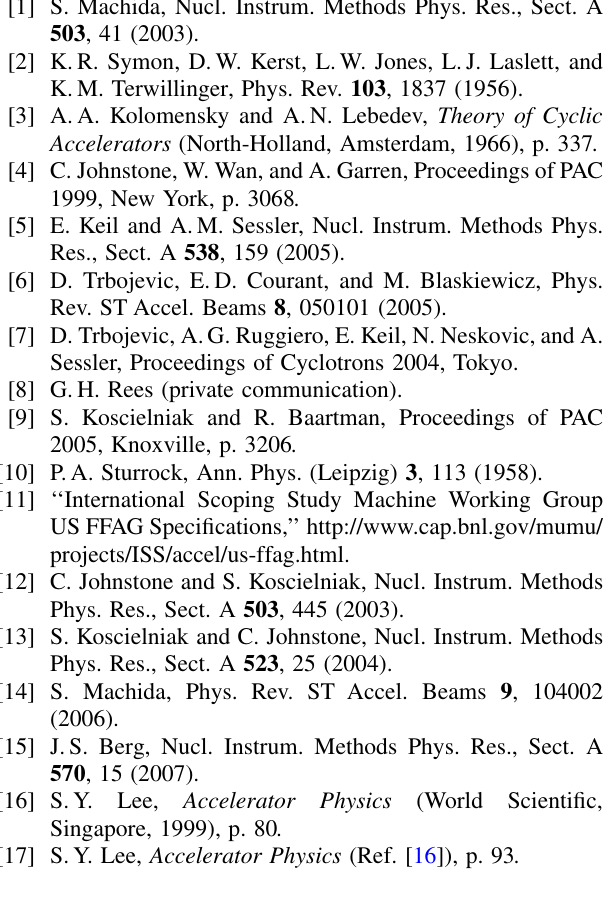
Figure 19 plots the squared values of rms deviations when 100 particles go through the random walk process in 1000 time steps. In each time step, 100 particles received random kicks whose rms strength is 1 at the beginning in one-dimensional space. There are two solid curves of red and black. The red one shows the case with the constant kick strength throughout the process and the black one shows the case with the kick strength decreasing as 1 It is clear that the solid red curve increases linearly with time step (time_step) as expected. The dashed red curve is the prediction. The solid black curve, on the other hand, can be fitted by the function of (cid:6) time step (cid:5) t the dashed black curve. With more than 1000 particles, the . The solid solid and dashed curves become indistinguishable. 1 (cid:8) t